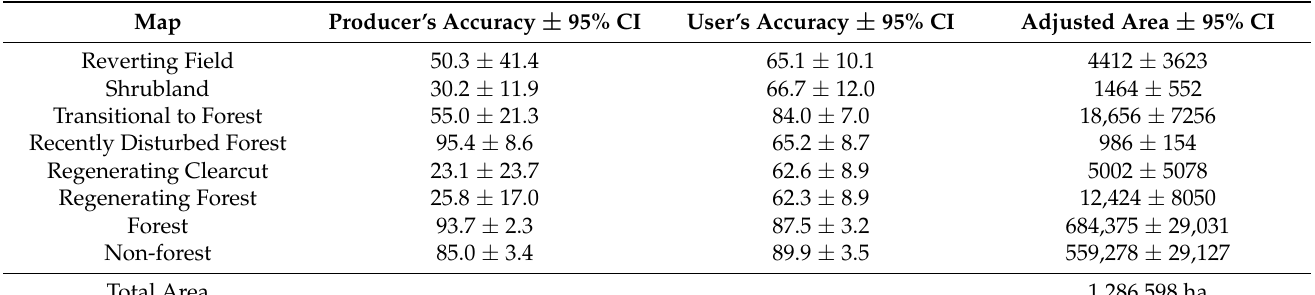
Table 4. Adjusted producer’s and user’s accuracy, and the estimated area (ha) of each vegetation type within Connecticut. Overall accuracy was 88.2% (95% CI